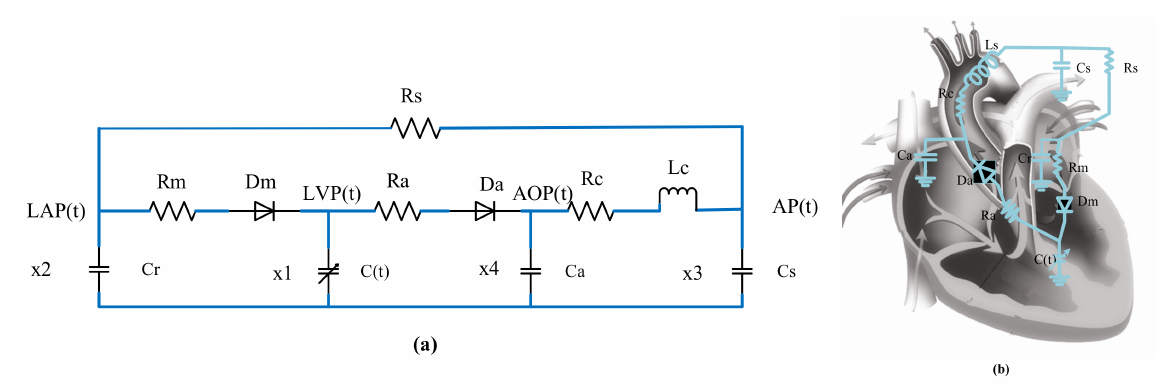
Figure 1. Electric circuit model. ( a ) 0D lumped-parameter circuit model of left ventricular circulation, ( b ) Equivalent circuit of blood